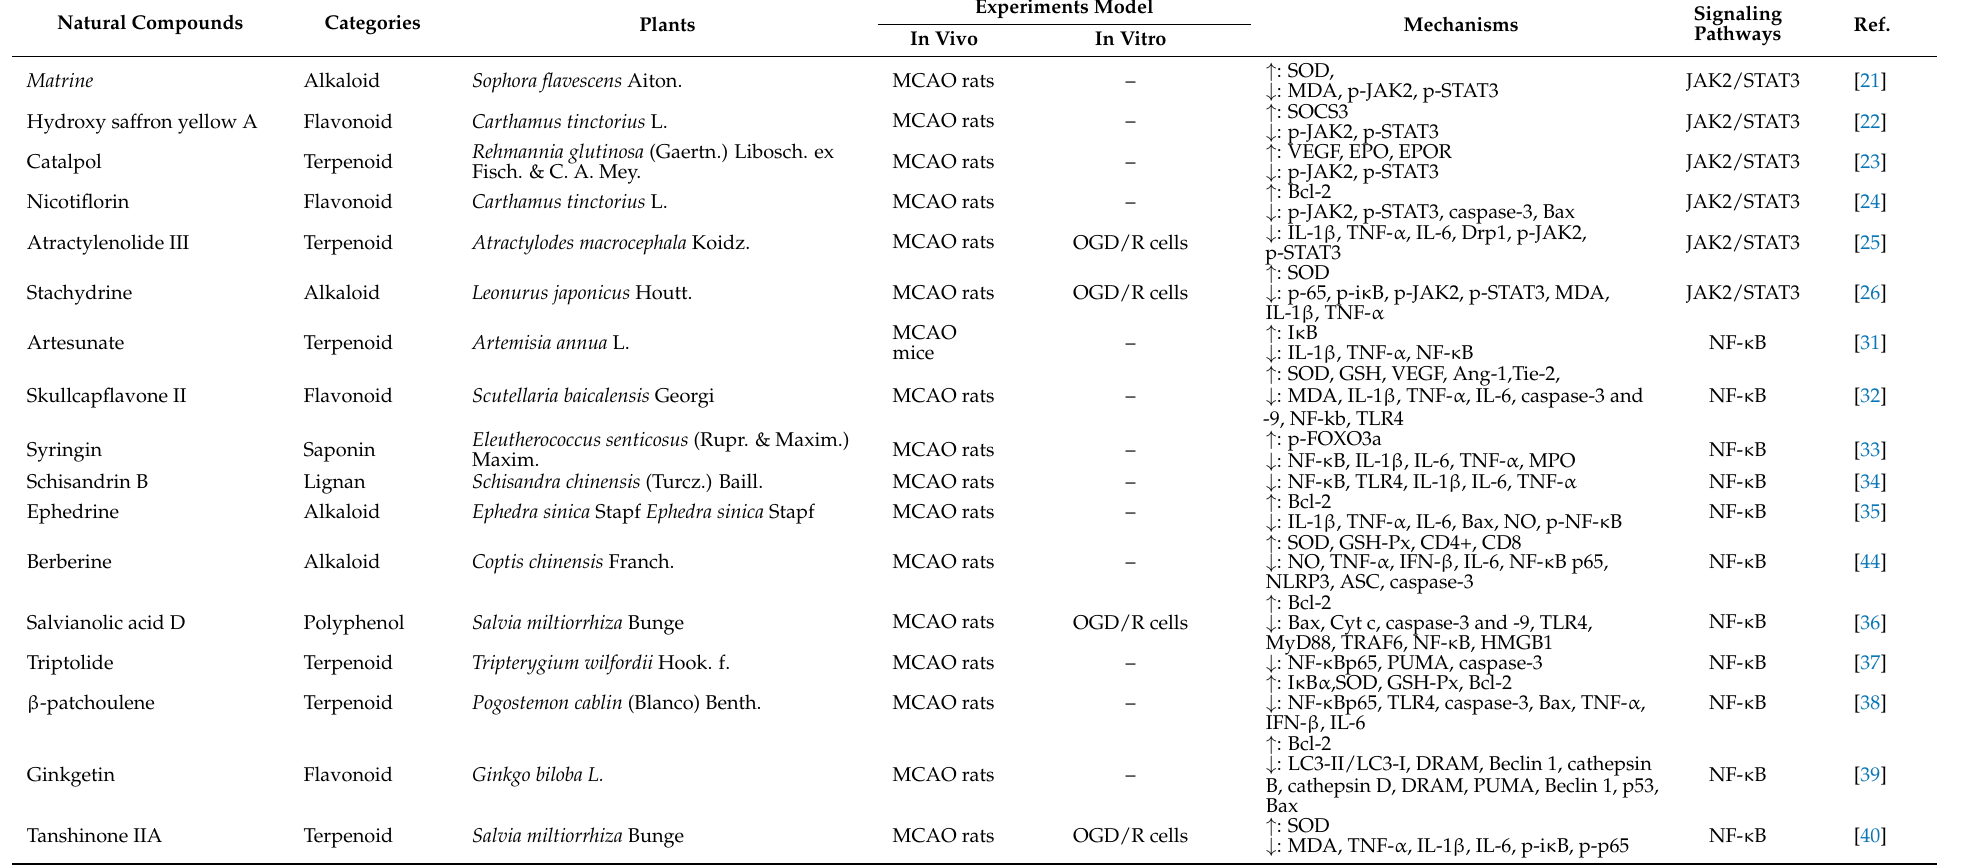
Table 1. Regulation effect of natural compounds from TCM on IS-related signaling